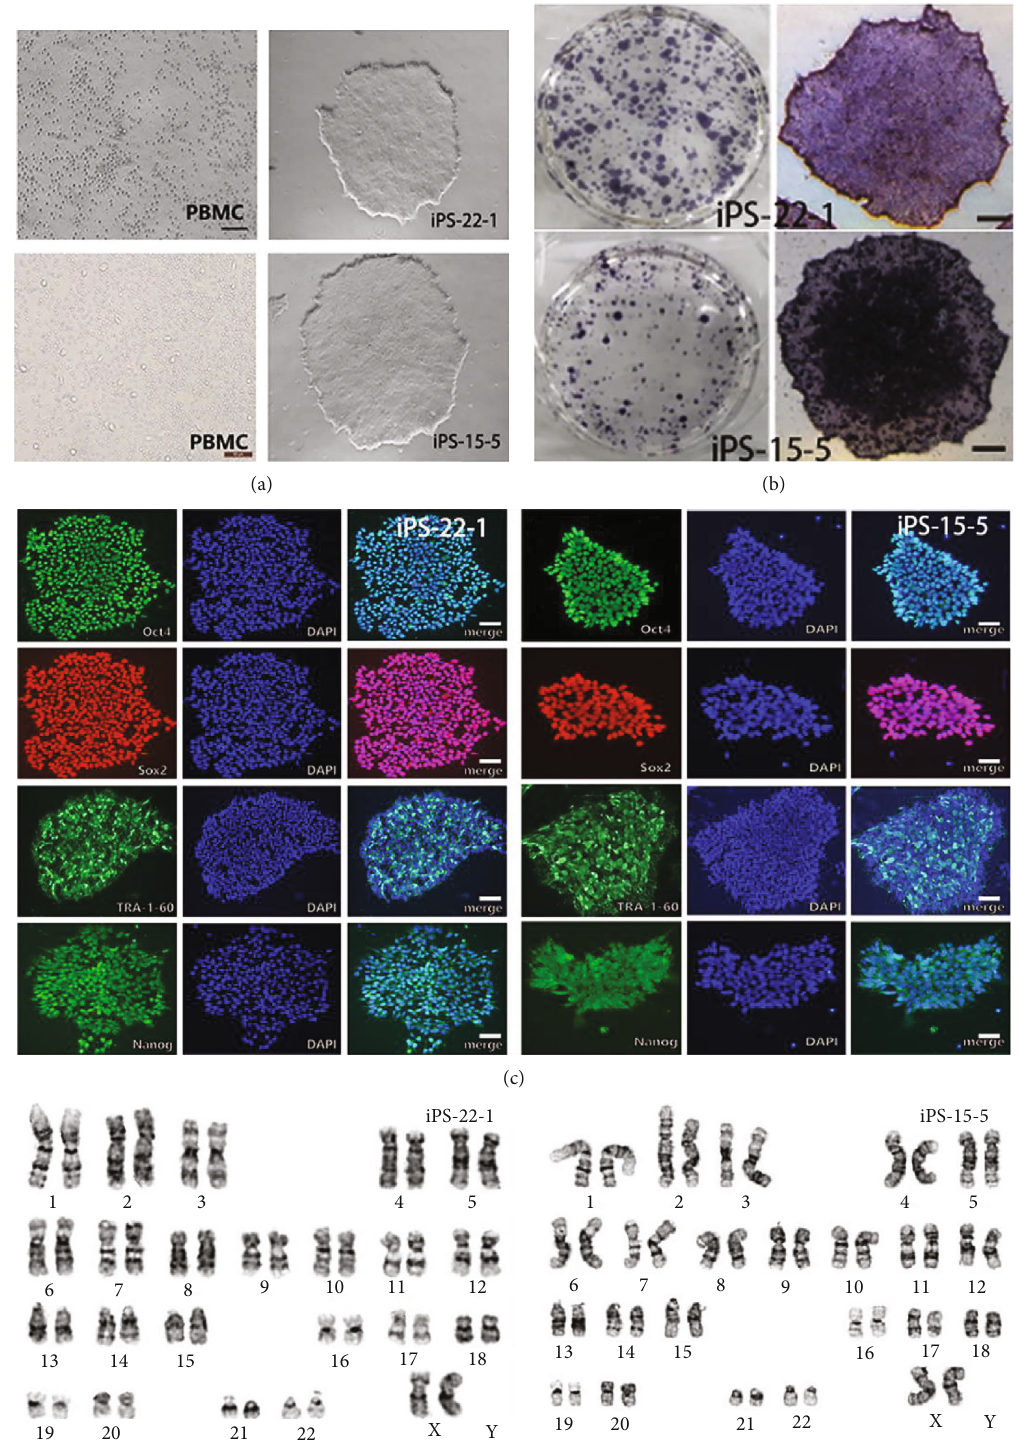
Figure 1: iPSC derived from SAD. iPSCs are similar to embryonic stem cells (ESCs) in morphology (a), which are characterized by colony- like growth, compact and tidy edges, small size, and high nuclear-cytoplasmic ratio. AP staining of iPSC-22-1 and iPSC-15-5 is positive (b). Speci fi c protein expression of ESC was used to detect the immuno fl uorescence reaction of iPSC (c). The karyotype of iPSC was detected by karyotype analysis (d). The karyotypes of iPS-22-1 were 46, XX and those of iPS-15-5 were 46, XX. Both strains were normal cell